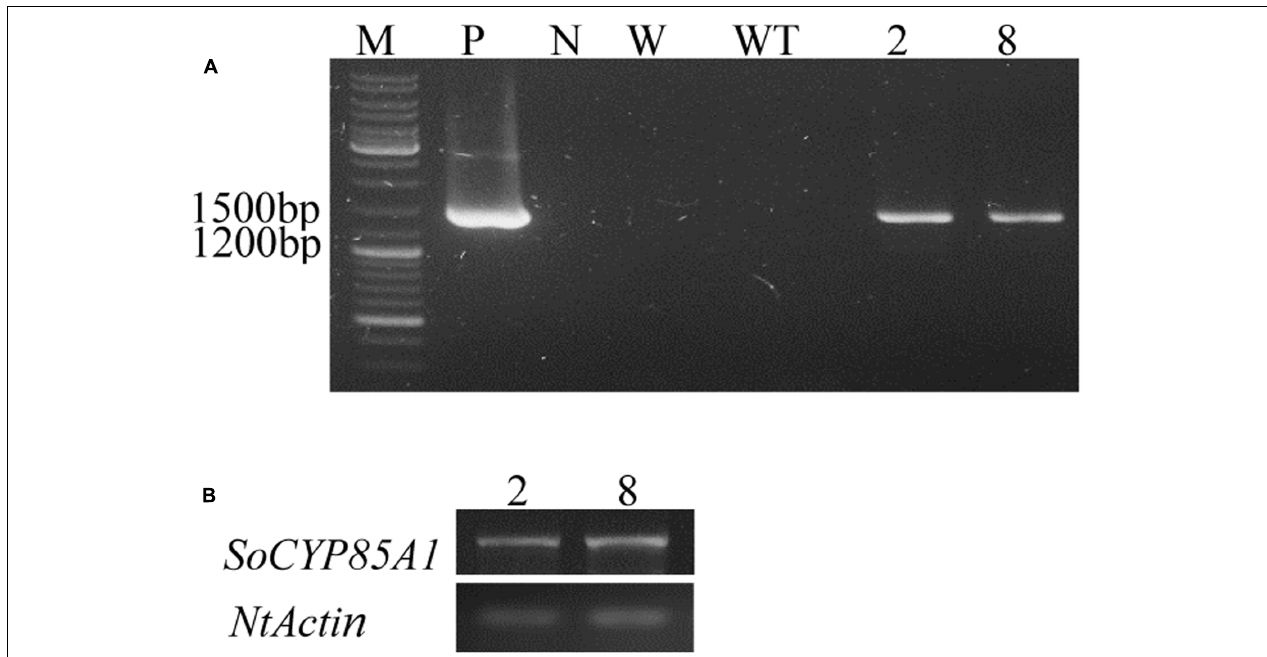
FIGURE 2 | Molecular identifications of transgenic tobacco lines. (A) PCR analysis of genomic DNA with the specific primers for the SoCYP85A1 gene. PCR amplification of a 1,392 bp fragment of the SoCYP85A1 gene in transgenic lines. (B) Expressions of SoCYP85A1 in transgenic lines. M, molecular marker; P, plasmid; N, negative control; W, water; WT, wild types; 2 and 8, transgenic